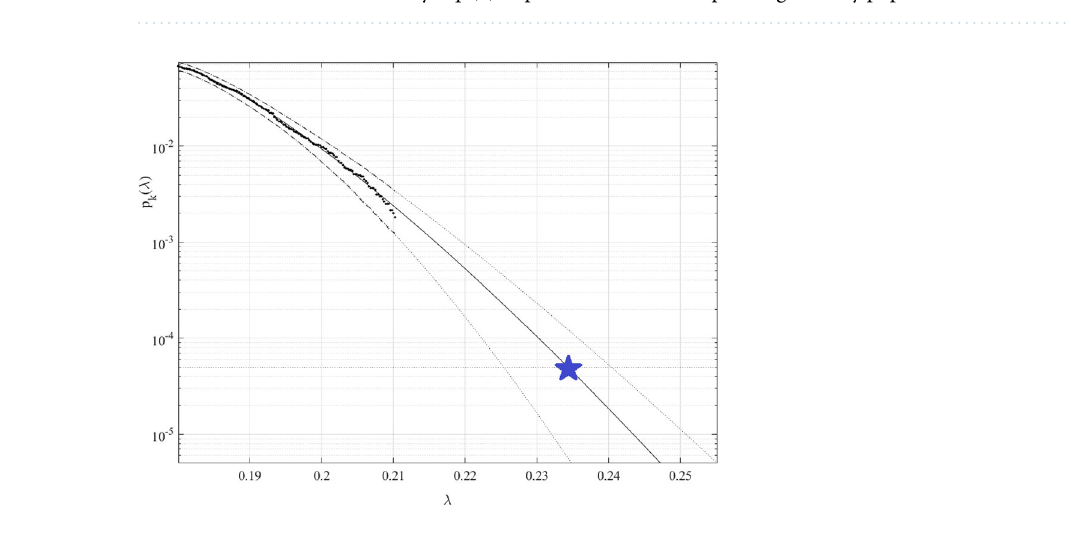
Figure 4. Death rate prediction. 100 years return level extrapolation of p k ( (cid:31) ) towards critical level (indicated by a star) in per cent of the local population. Extrapolated 95% CI indicated by dotted lines. Percentage of the local population on the horizontal